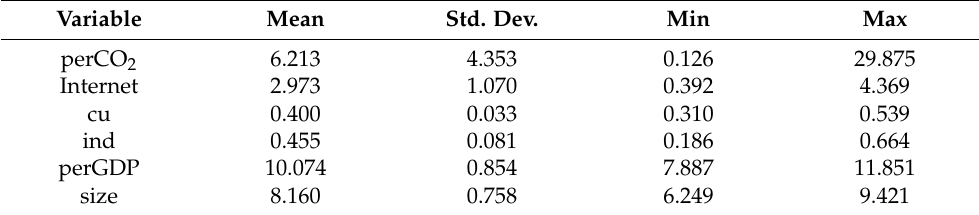
Table 1. Descriptive statistics of